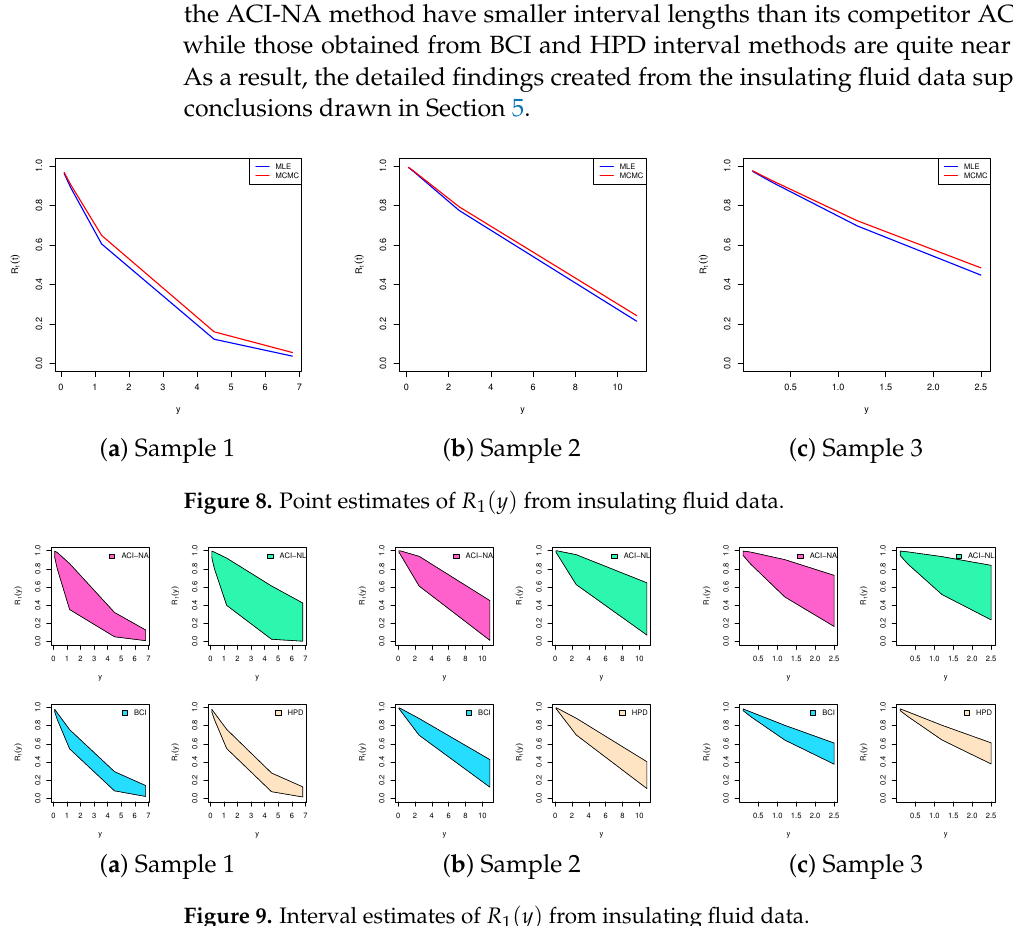
Figure 9. Interval estimates of R 1 ( y ) from insulating fluid